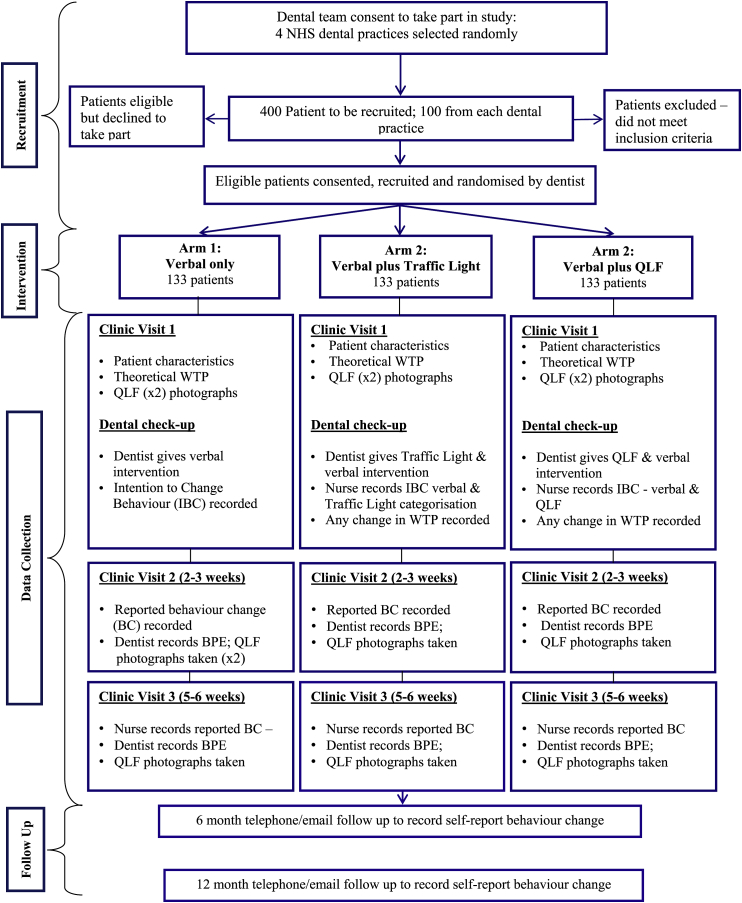
Study flow diagram.